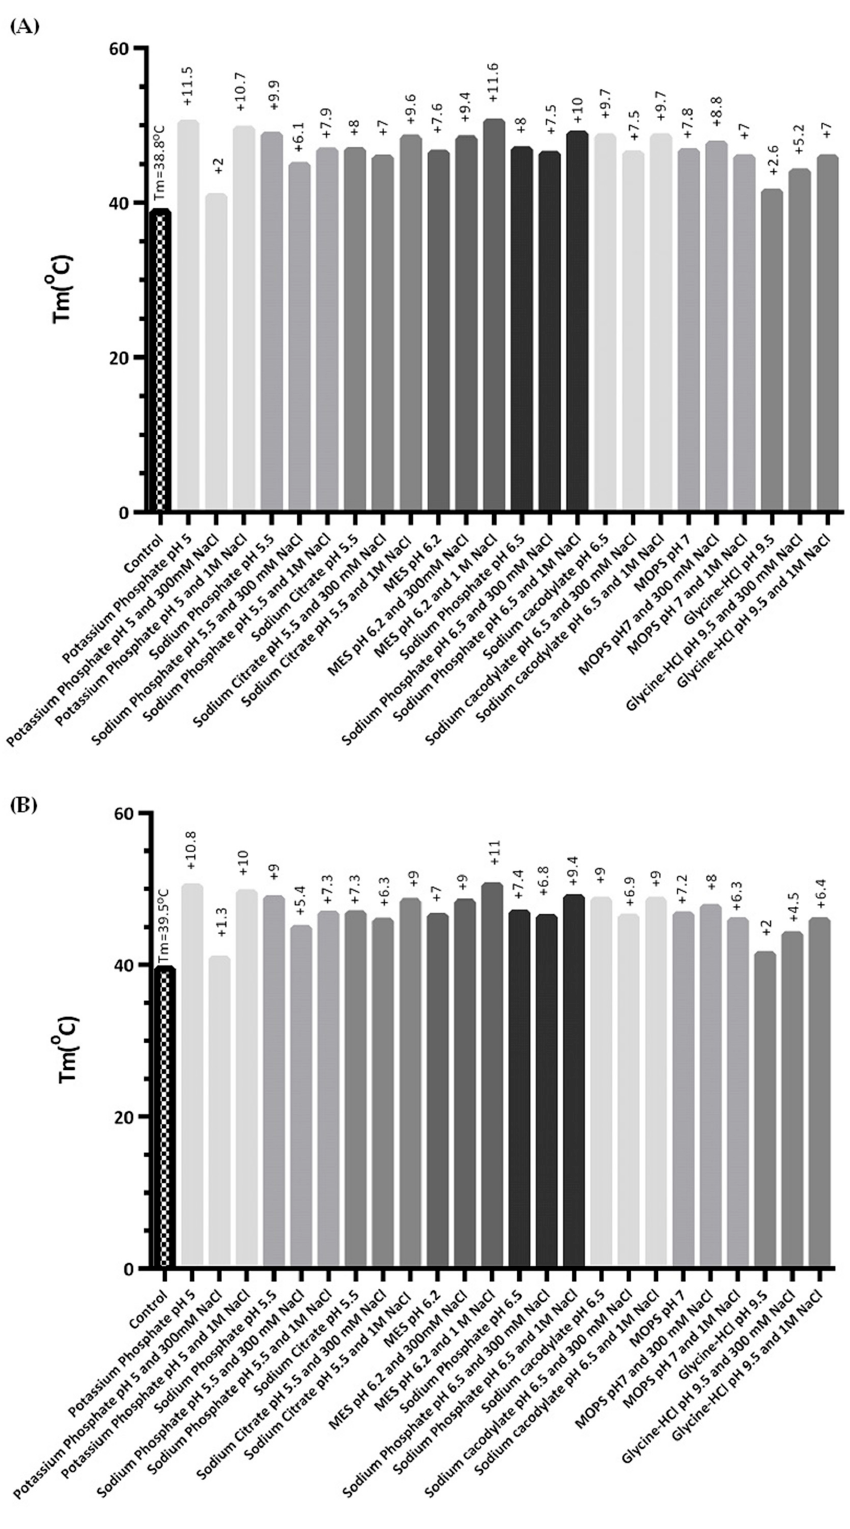
Figure 4. Graphical representation of the Tm values of hSCOMT in the presence of the buffers that gave a clear thermal transition. The control experiment was prepared using ( A ) 10 mM Tris-HCl pH 7.8 and 0.5 M [C 4 min]C l . ( B ) 50 mM Tris-HCl pH 7.5, 0.5 M [C 4 mim]Cl, 50 mM NaCl, 2 mM MgCl 2 , and 10 mM